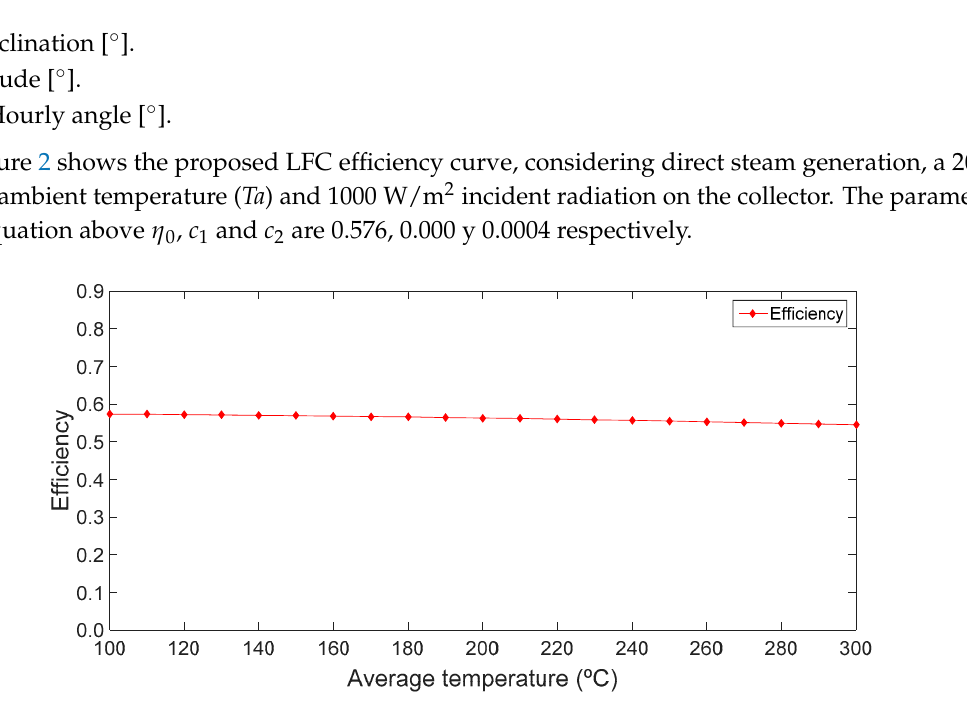
Figure 2. LFC efficiency curve, Ta = 20 °C, Ibc = 1000 W/m 2 .